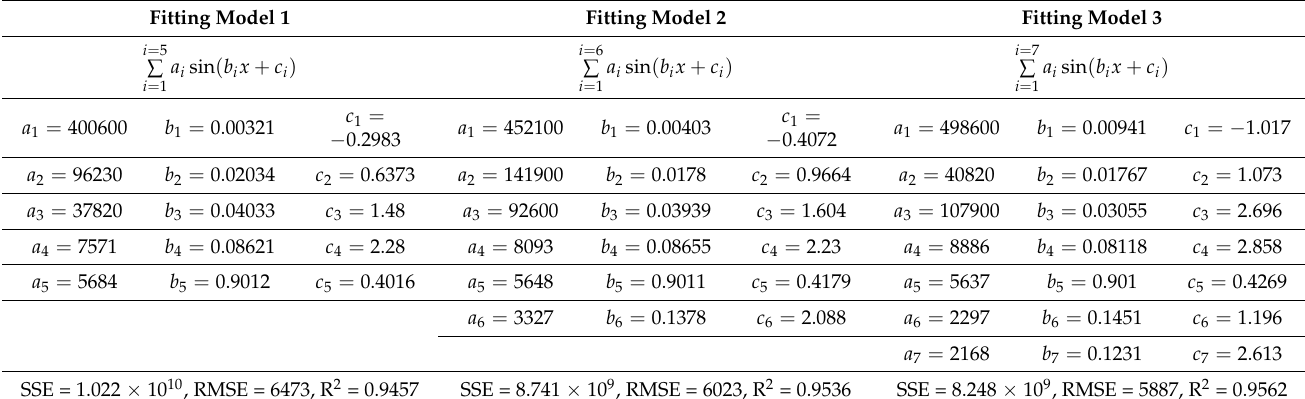
Table 8. Used mathematical fitting models for U.S.A. data with optimized coefficients.